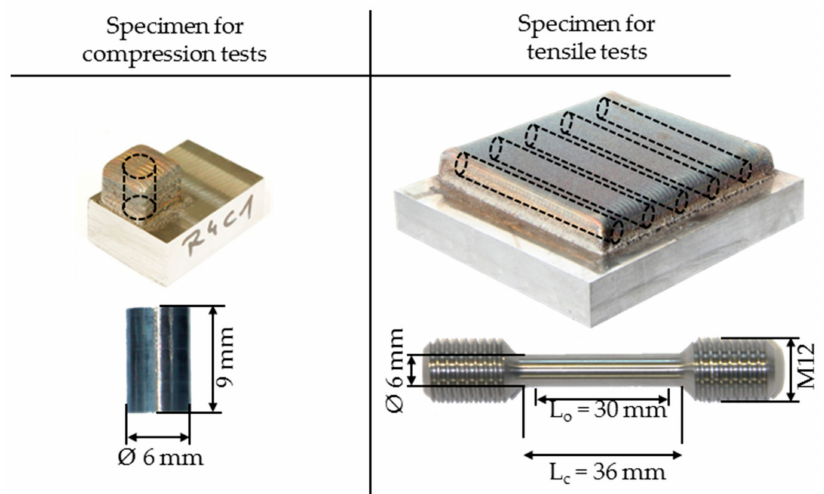
Figure 4. Production and geometry of the specimens for the tests of mechanical properties. To eliminate boundary effects, the specimens are machined out of relatively large